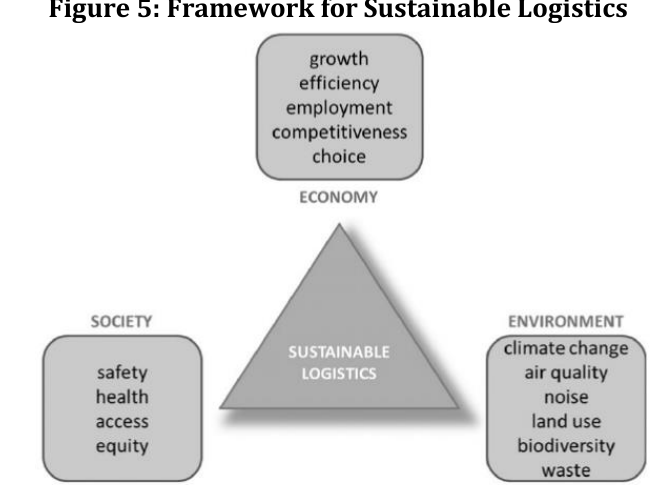
Source : Macharis, Melo & Woxenius, 2014, p.